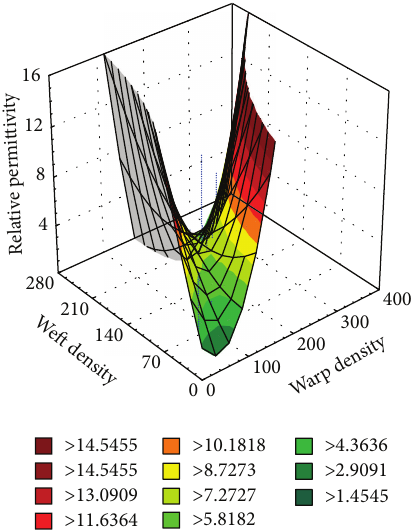
Figure 10: Simultaneous influence of the technological density (yarns per 1dm) in direction of warp and weft on the relative electrical permittivity of natural cellulosic weaves. 3D surface plot (NEW.STA 10v ∗ 22c) 𝑧 = 2.6156 −0.0715⋅𝑥 + 0.1591⋅𝑦 + 0.001⋅𝑥 2 − 0.0018 ⋅ 𝑥 ⋅ 𝑦 + 0.0003 ⋅ 𝑦 2 .